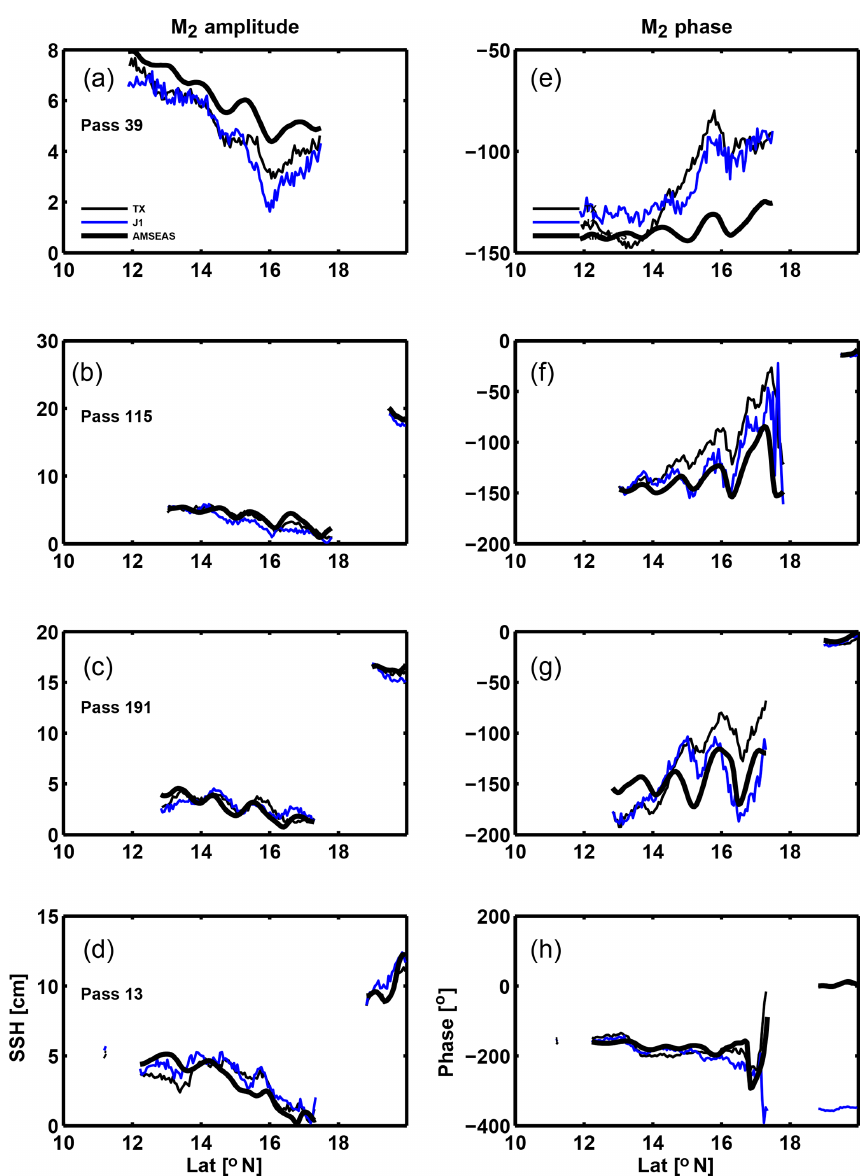
Figure A2. Comparison of satellite-derived and AMSEAS phase-locked tides in the Caribbean Sea: ascending